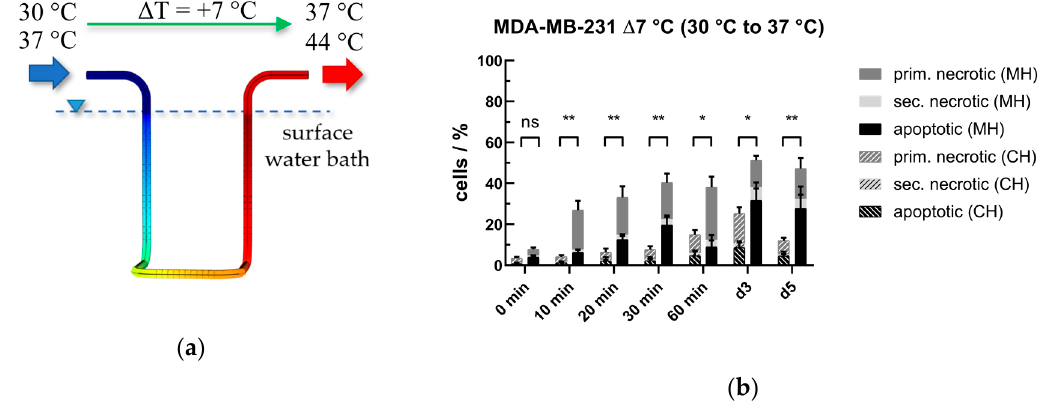
Figure 13. ( a ) Exemplary radial temperature profile for heating the cells by a Δ T of +7 °C and ( b ) cell death forms after conventional or microwave heating of MDA-MB-231 breast cancer cells from 30 °C to 37 °C. Significance test was conducted using Kruskal-Wallis test with uncorrected Dunn´s multiple comparison from three independent experiments, each measured in duplicates* ( p < 0.1), ** ( p < 0.01).